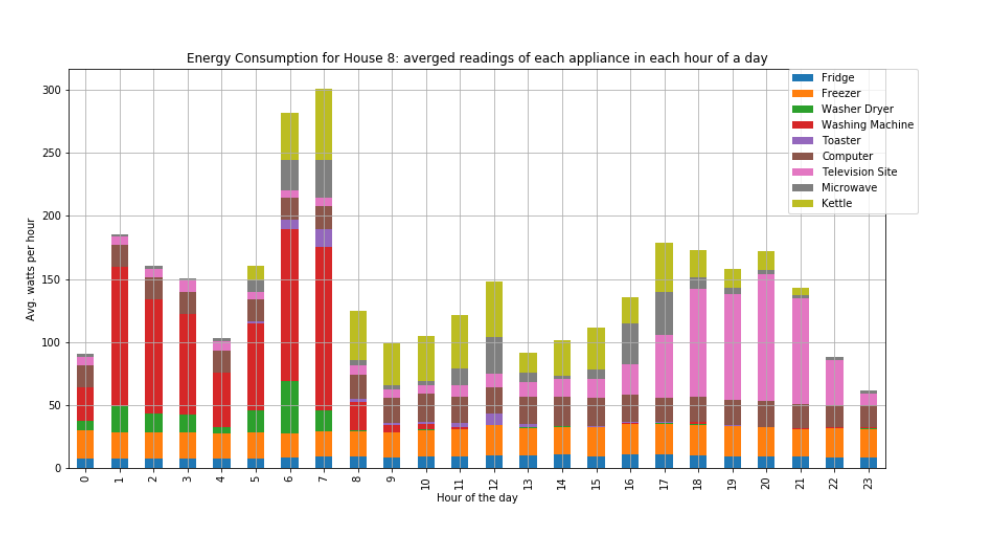
Figure A13. The average consumption per hour of home appliances for house 8 with two occupants.